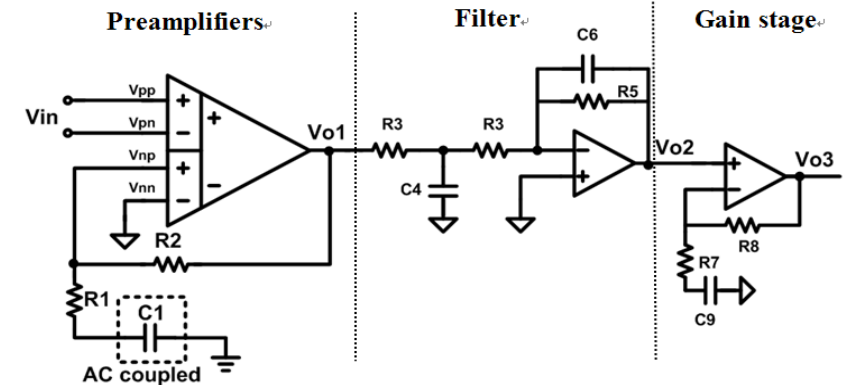
Figure 4. The acquisition